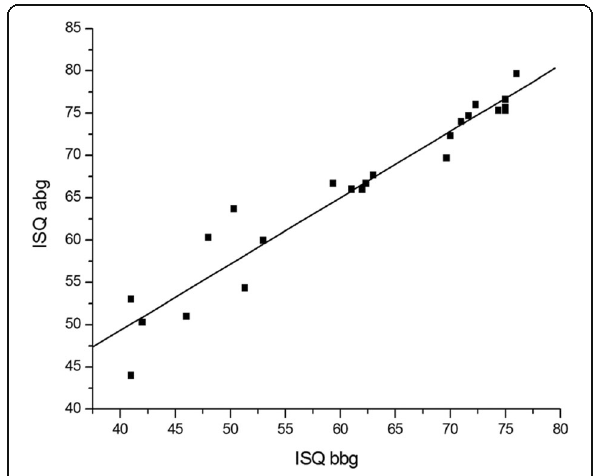
Fig. 3 The correlation between implant stability quotient after bone graft (ISQ abg) and implant stability quotient before bone graft (ISQ bbg)